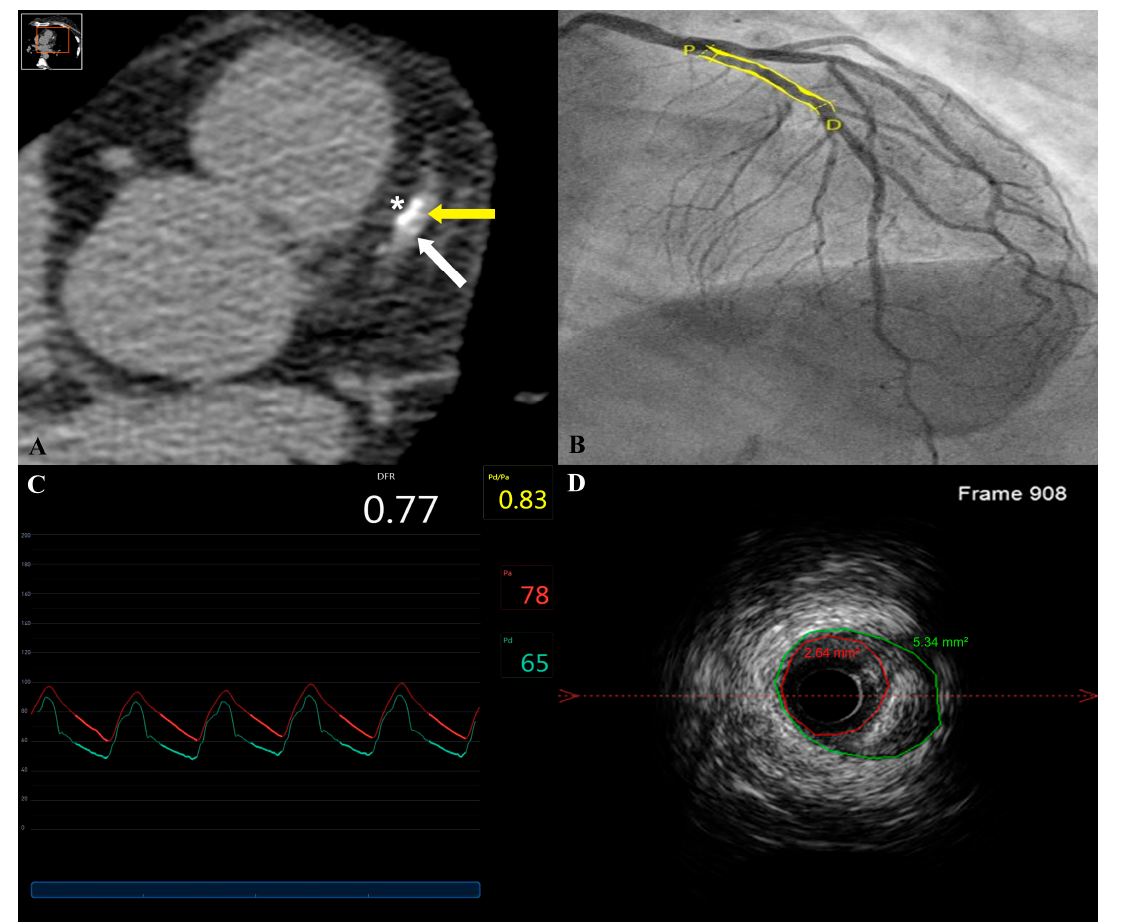
Figure 3. In-stent restenosis of a DREAMS-2G stent implanted in a proximal left anterior descending artery. In-stent restenosis by Coronary Computed Tomography Angiography 6-months post-stent implantation was suspected with a minimal in-stent lumen area (MLA) of 2.3 mm 2 . Panel ( A ) shows one slice of the CT without contrast, on which the proximal tantarum of the stent is visible (white arrow), the lumen of the artery (yellow arrow) is free from any metallic stent struts with blooming effect, while some parietal calcifications are visible (*). In-stent restenosis was confirmed by a coronary angiogram 8 months post-implantation with a minimal lumen diameter of 1.41 mm by quantitative coronary angiography (Panel ( B )) and a pathological fractional flow reserve (0.77) (Panel ( C )). An intravascular ultrasound (IVUS) pullback demonstrated in-stent restenosis with an MLA of 2.64 mm 2 (Panel ( D